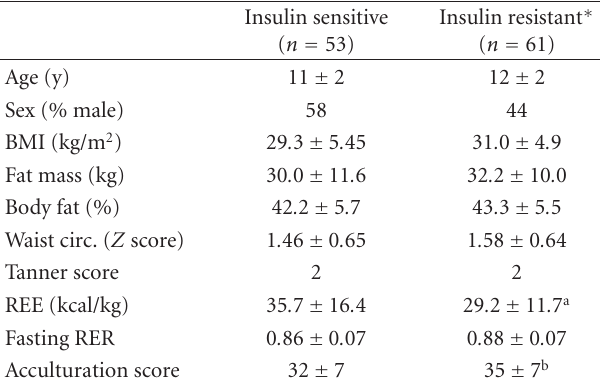
Table 1: Subject characteristics.